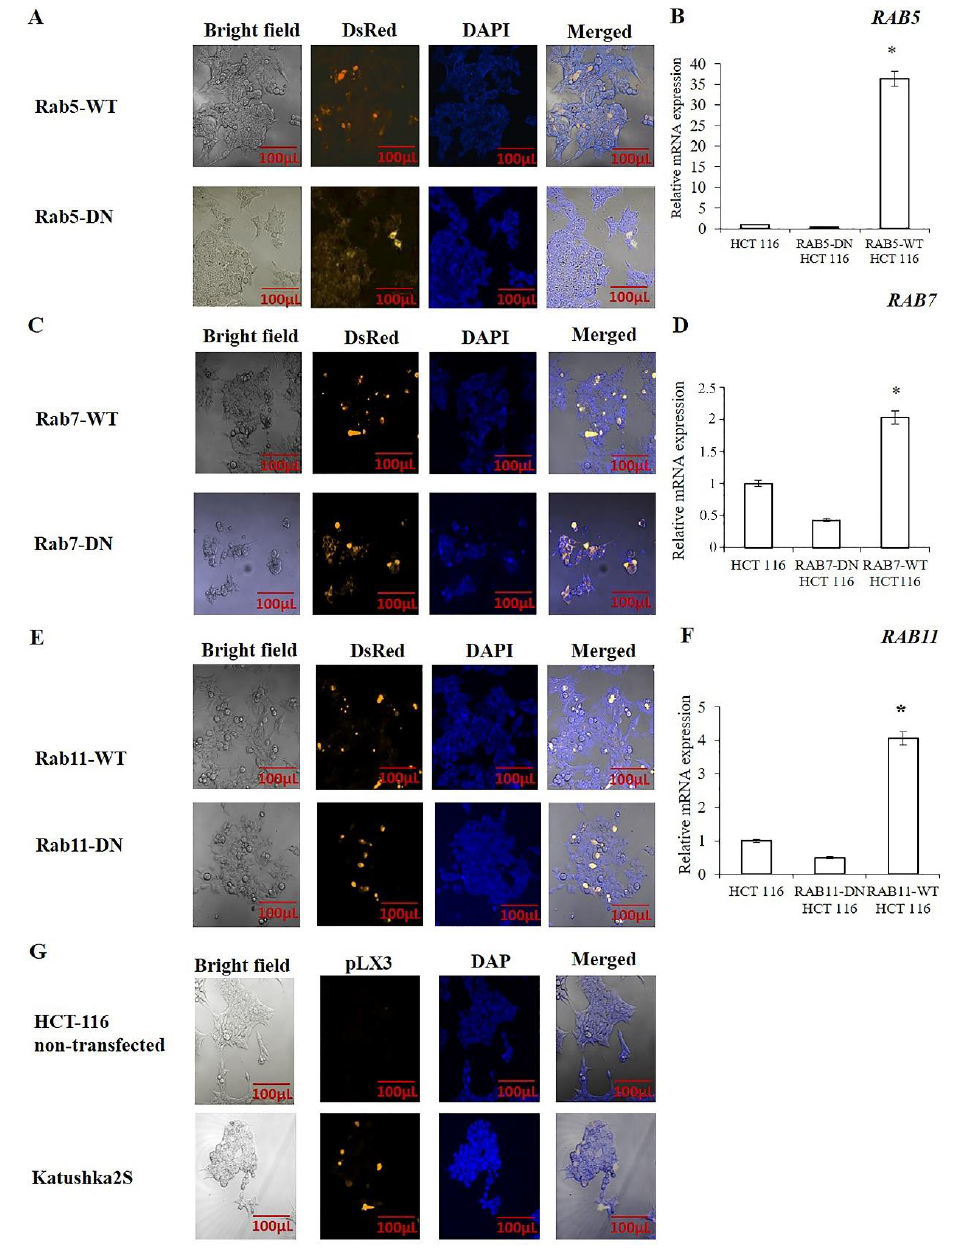
Figure 1. Expression of the Rab5, Rab7 and Rab11 in HCT-116 cells. Cells were transfected with pDsRed-rab5-WT, pDsRed-rab5-DN, pDsRed-rab7-WT, pDsRed-rab7-DN, pDsRed-rab11-WT and pDsRed-rab11-DN and protein expression was observed using 556 nm excitation wavelengths. ( A ) IF analysis of the cells transfected with pDsRed-rab5-WT and pDsRed-rab5-DN. ( B ) The changes in transcript level of RAB5 in pDsRed-rab5-WT and pDsRed-rab5-DN transfected HCT116 cells. ( C ) IF analysis of cells transfected with pDsRed-rab7-WT and pDsRed-rab7-DN. ( D ) The changes in transcript level of RAB7 in pDsRed-rab7-WT and pDsRed-rab7-DN transfected HCT116 cells. ( E ) IF analysis of cells transfected with pDsRed-rab11-WT and pDsRed-rab11-DN. ( F ) The changes in transcript level of RAB11 in pDsRed-rab11-WT and pDsRed-rab11-DN transfected HCT116 cells. ( G ) IF analysis of cells transfected with pLX303-Katushka2S. ( n = 3 for each experiment. In (A, C, E, G), transfection e ffi ciency was measured using ImageJ software. In ( B , D , F ), * p value was calculated using One Way Anova and Tukey Test. * p <